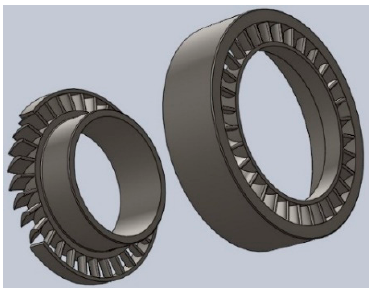
Figure 4. Single-stage and multi-blade turbodrill stator and rotor model.